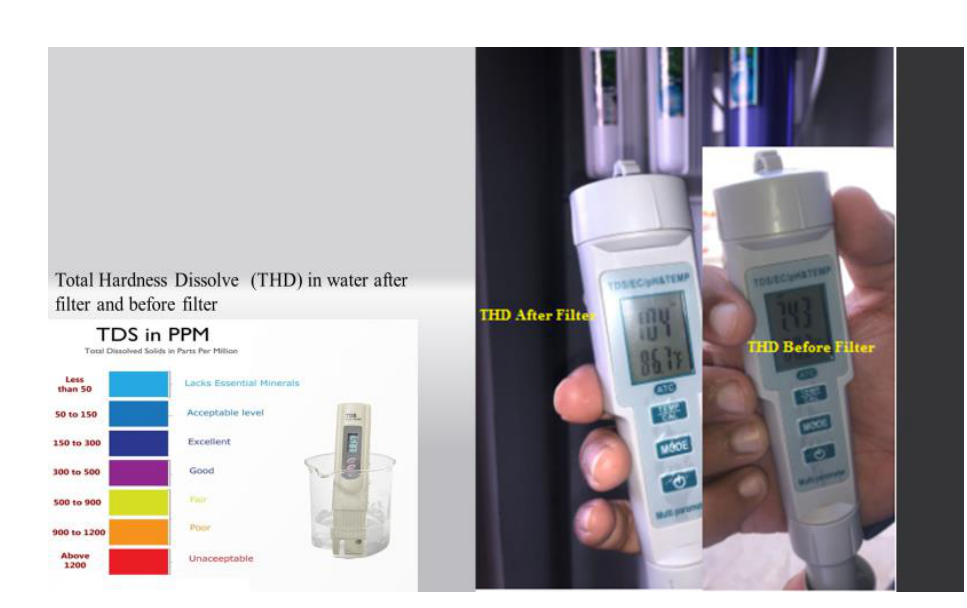
Figure 10. THD after filter and before filter.